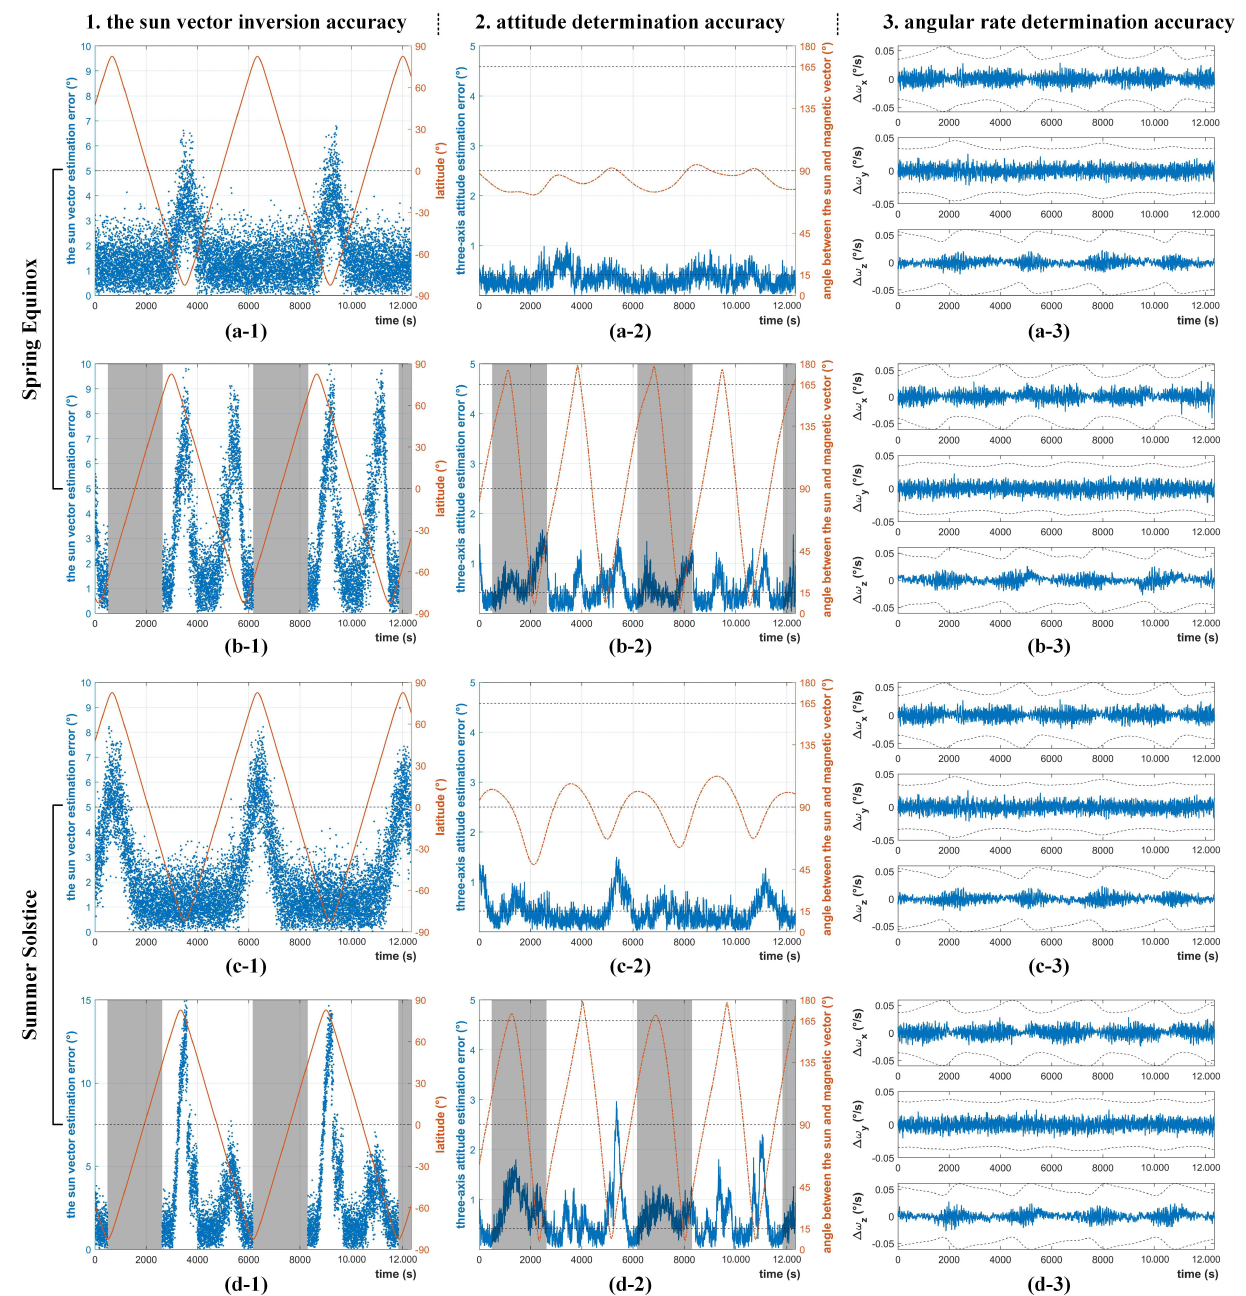
Figure 17. Performance of IPSS to support three-axis attitude determination in various orbits and seasons. ( a-1 , a-2 , a-3 ) 18:00 sun − synchronous orbit at the Spring Equinox. ( b-1 , b-2 , b-3 ) 12:00 sun − synchronous orbit at the Spring Equinox. ( c-1 , c-2 , c-3 ) 18:00 sun − synchronous orbit at the Summer Solstice. ( d-1 , d-2 , d-3 ) 12:00 sun − synchronous orbit at the Summer